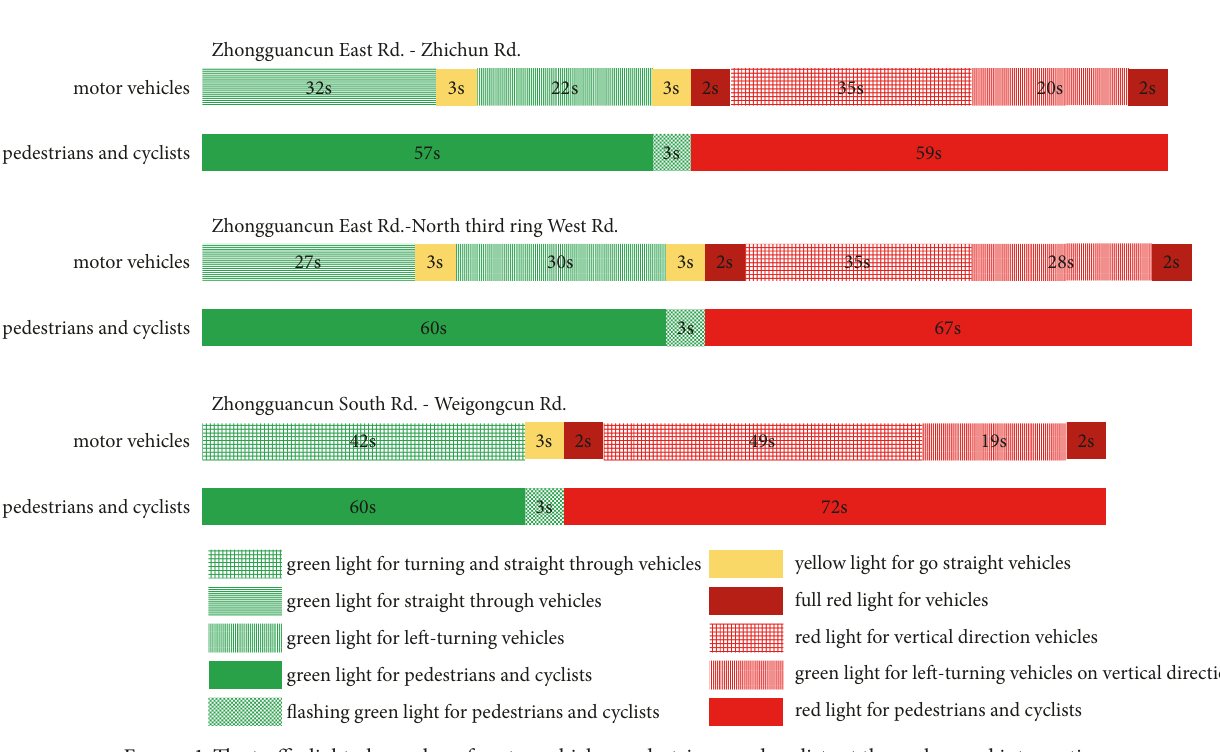
Figure 1: The traffic light phase plan of motor vehicles, pedestrians, and cyclists at three observed intersections.